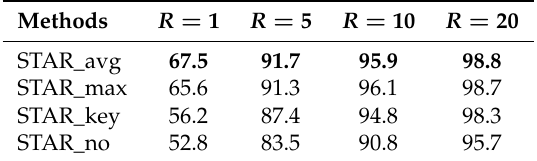
Table 2. Evaluation of three different pooling manners on iLIDS-VID. Bold values indicate the best performance.